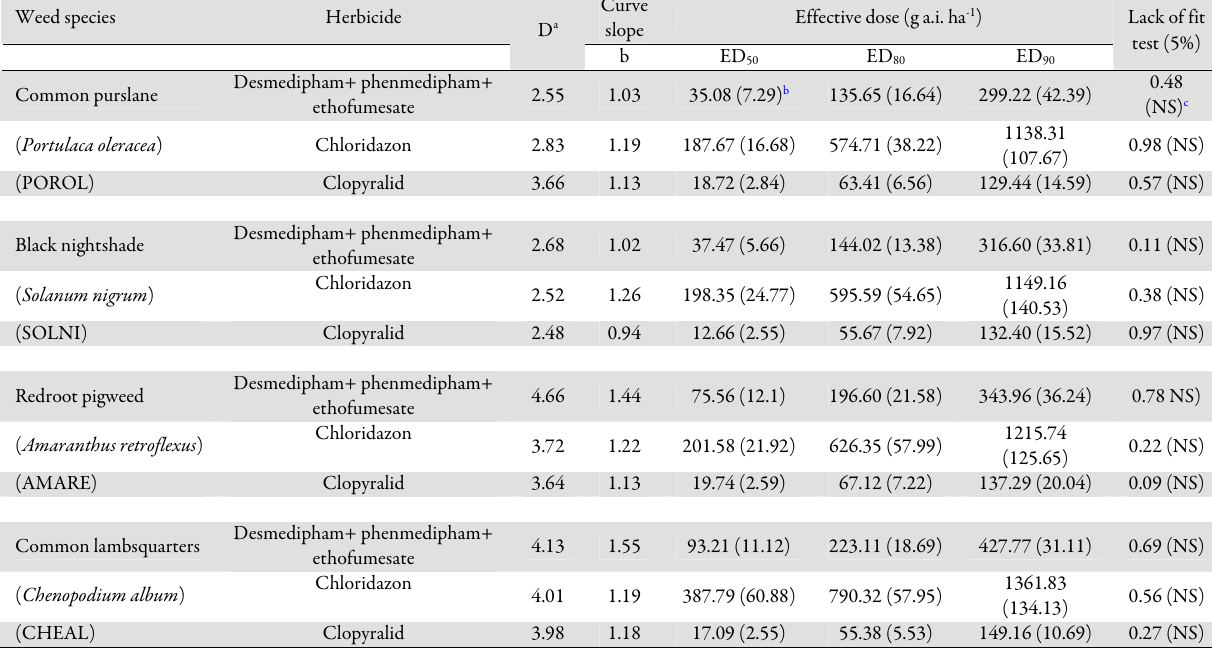
Tab. 2. Summary of dose–response regressions of dry matter at days after treatment (DAT) (four- to six-true leaf stage) for each species and experiment. Asymptotic standard errors are in parentheses. In all four experiments the test for lack of fi t was not signi fi cant, indicating that the logistic model was able to describe the data better than an ordinary